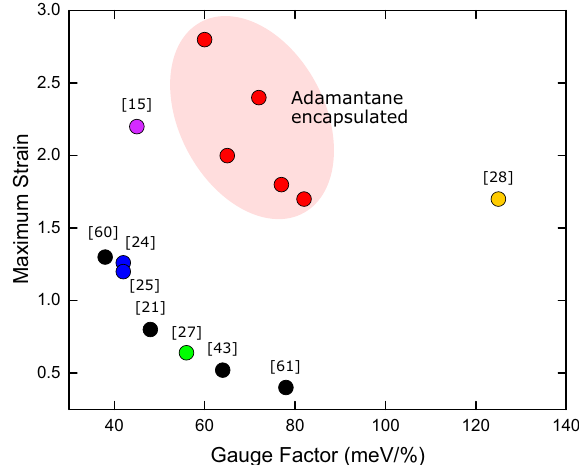
Fig. 8 Comparison between the strain engineering experiments in the literature. Maximum strain versus gauge factor in single-layer MoS 2 . Red dots: results obtained in this work. Black dots: bare monolayers from other works 21,43,60,61 . Blue dots: monolayers covered with a PDMS fi lm 24,25 . Purple dot: monolayer MoS 2 fl ake clamped to the substrate with a metal contact 15 . Green dot: single- layer MoS 2 encapsulated with a PMMA fi lm 27 . Yellow dot: monolayer MoS 2 covered with a PVA coating 28